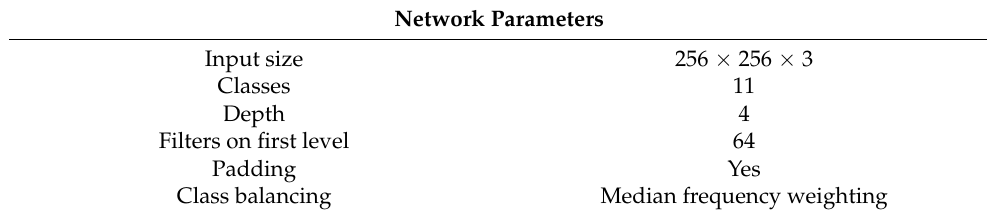
Table 10. Network parameters for UNet on